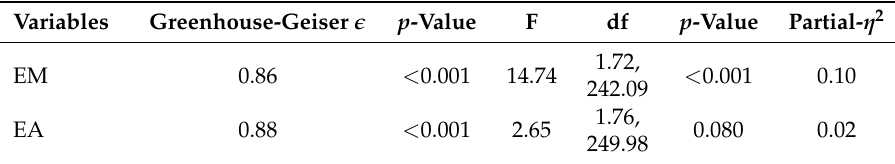
Table 5. Results of the repeated measures ANOVA for energy monitoring (EM) and attitude towards environmental issues